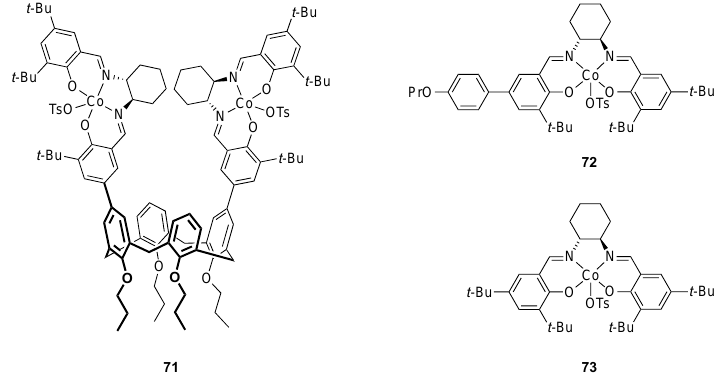
Figure 29. Calix[4]arene-based dimeric Co–salen complex 71 and monomeric analogues 72 and 73 .